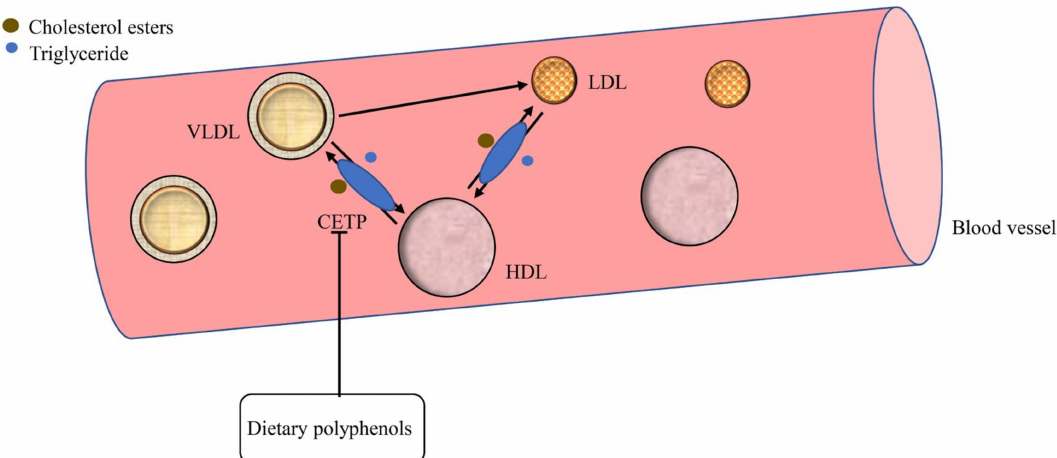
Figure 3. CETP-mediated LDL metabolism. CETP, cholesterol esters transfer protein; HDL, high-density lipoprotein.